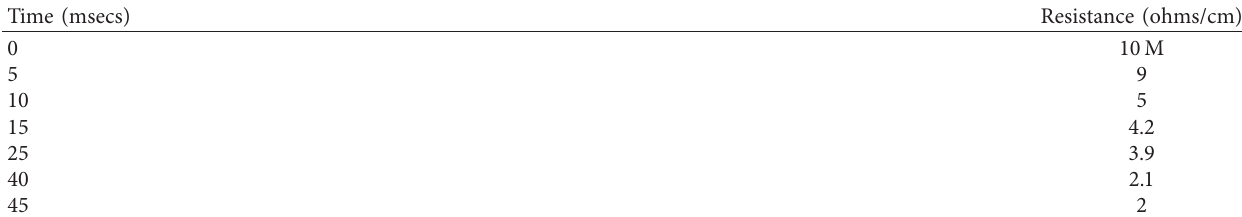
Table 2: Conductivity Vs time of AgNP at room temperature.